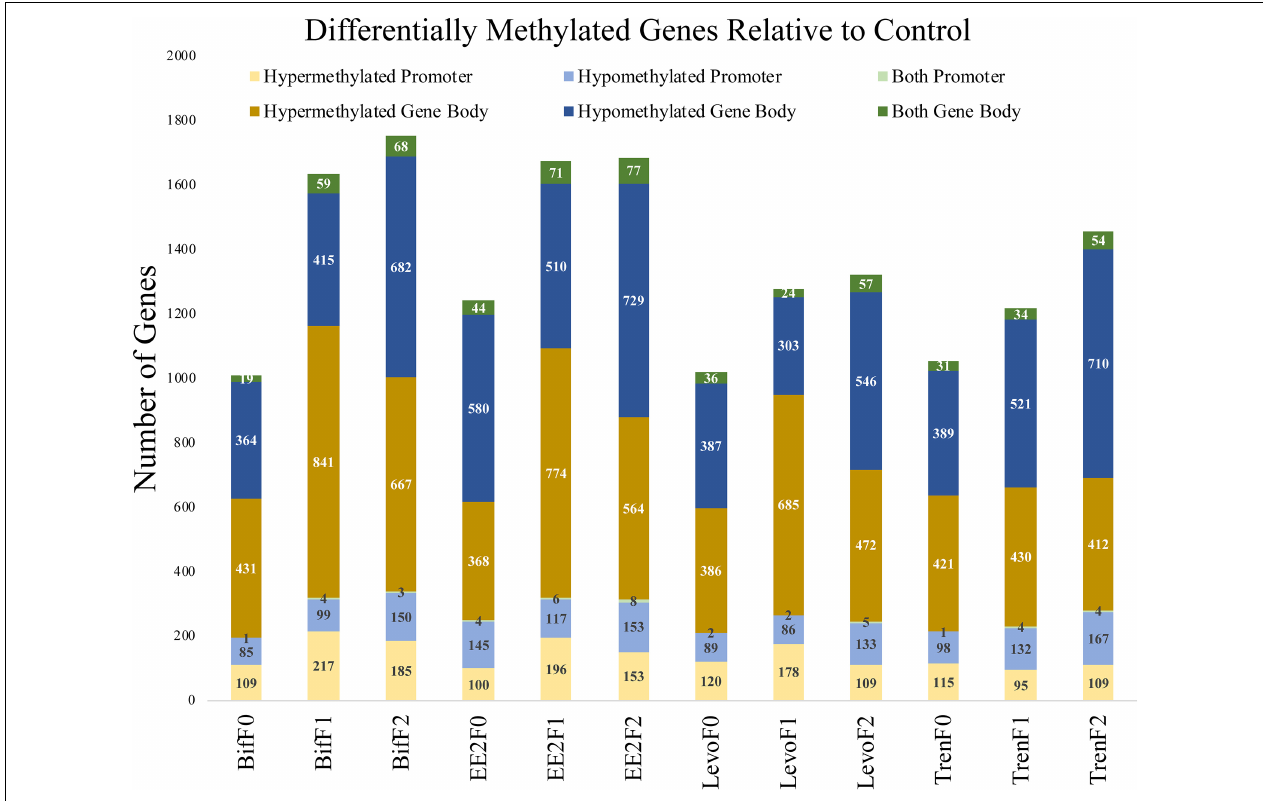
FIGURE 3 | Bar graph depicting the differential methylation relative to control by treatment (Bif, EE2, Levo, Tren), generation (F0, F1, F2), directional methylation change (hyper, hypo) and region (promoter, gene body) for all genes as informed by the M. beryllina transcriptome. Differential methylation was more prominent in the gene body than the promoter regions for all treatments and generations. While most genes only showed a singular directional change in methylation by region relative to the control, a minority showed both hypo and hyper methylation at different loci in the same